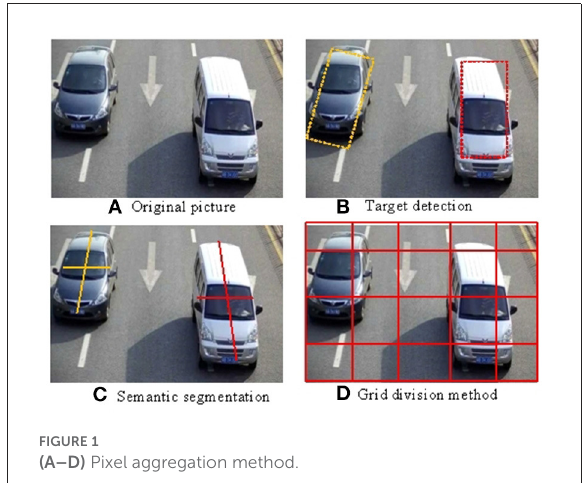
FIGURE1 (A–D) Pixel aggregation